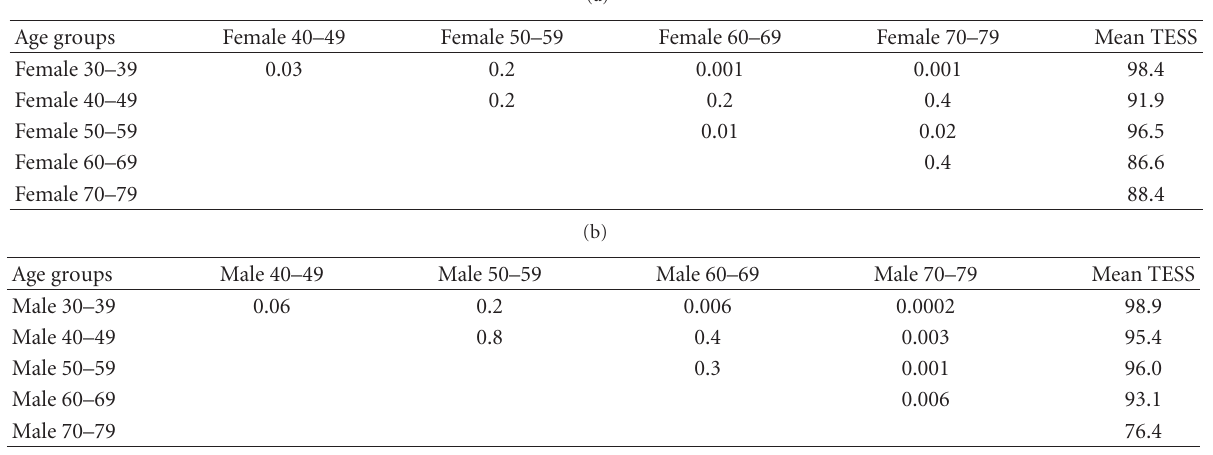
Table 2: The TESS at di ff erent age groups and genders and statistical relevance ( P value given).